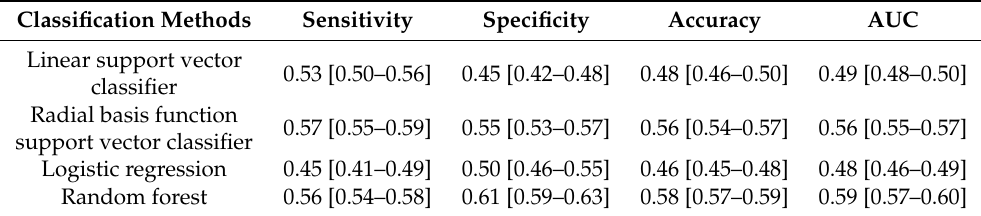
Table 2. Performance measures of the four ML radiomic classifiers for benign calcification versus malignant calcification.